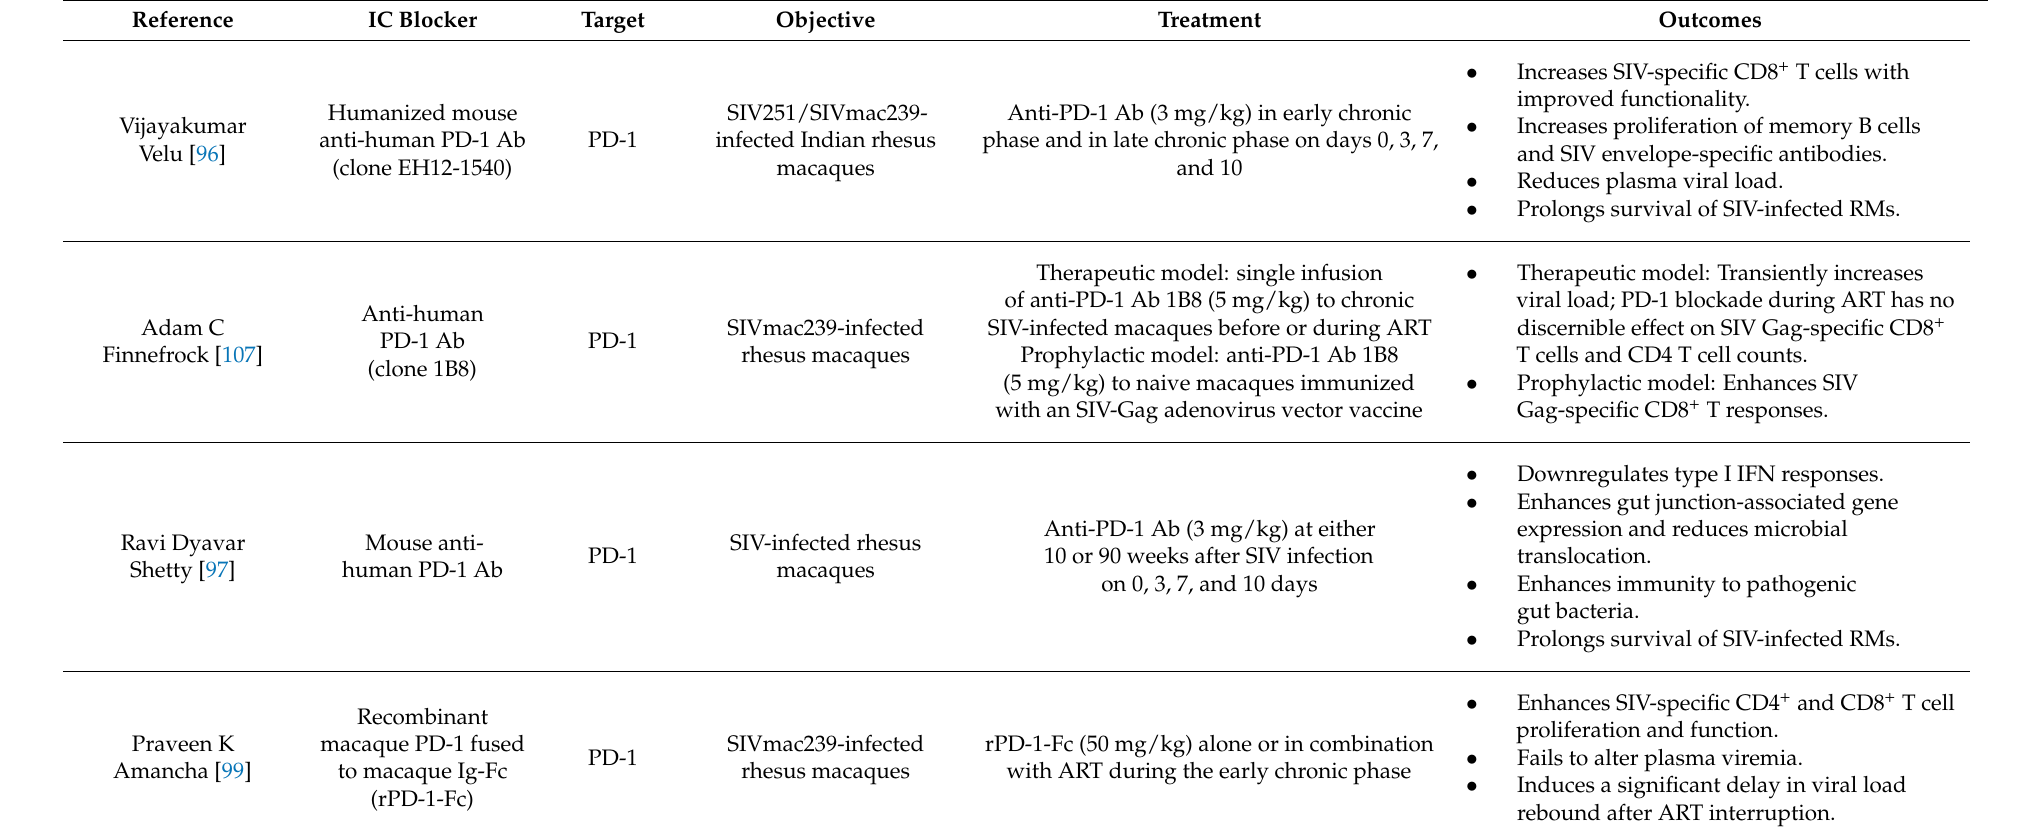
Table 4. Summary of therapeutic effects of IC blockers in macaque